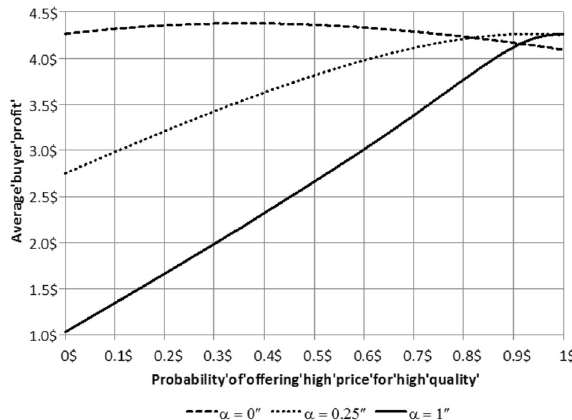
Fig. 4 Buyer’s expected profit as a function of the probability of offering high price for high quality in the reciprocity